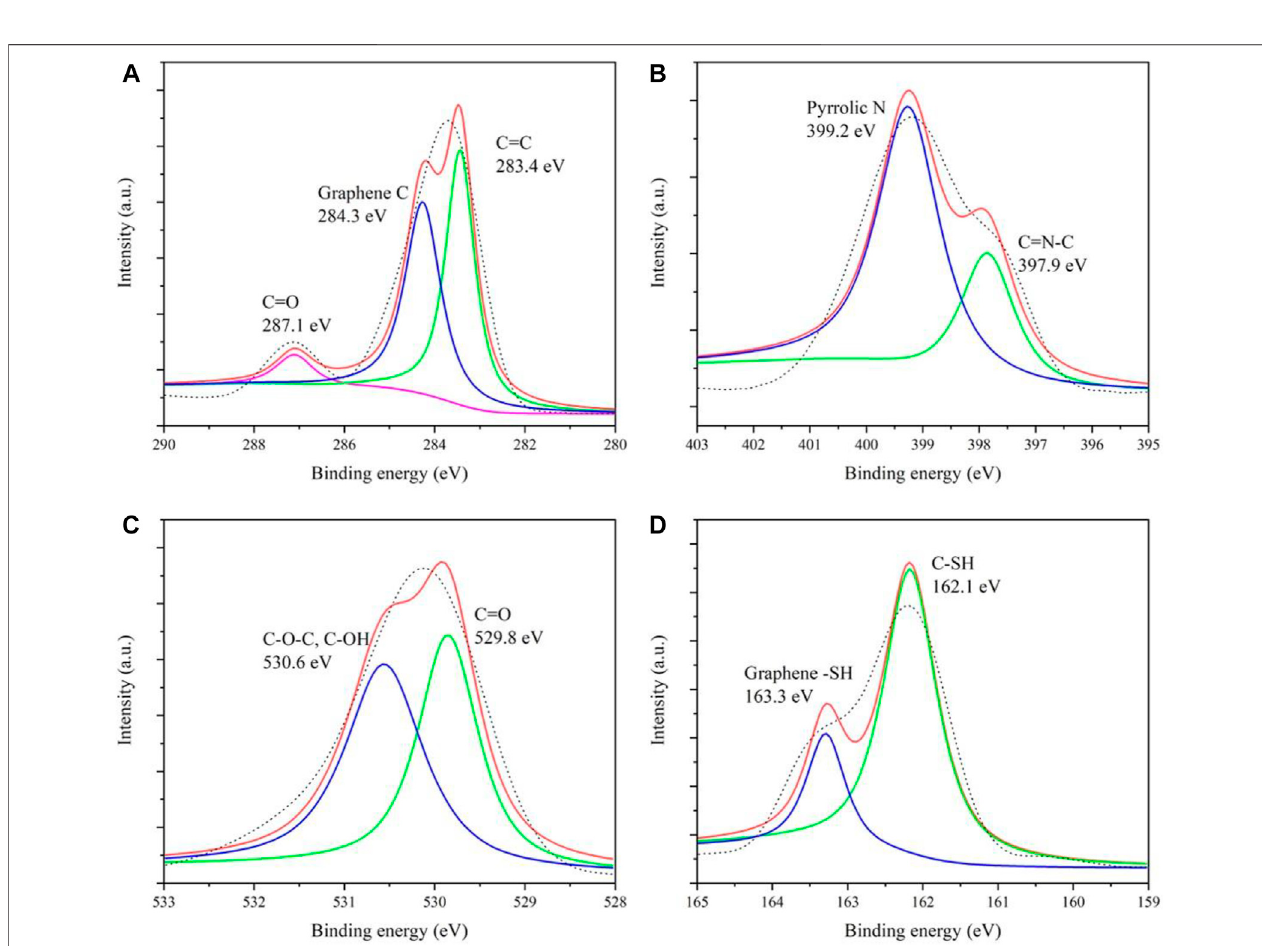
clearly. XPS has con fi rmed that the CDs have hydroxyl, carbonyl, amino, and sulfhydryl groups, which is why the CDs can easily complex Ag + ions.